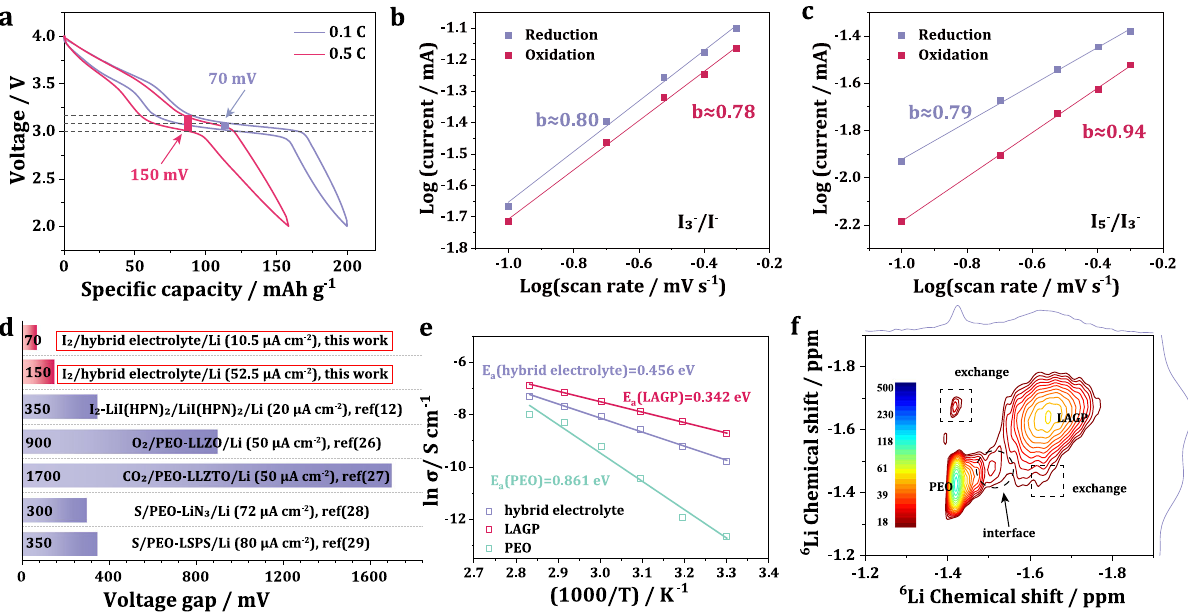
Fig. 5 Reaction kinetics and Li ions transport property in the all-solid-state LIB. a Voltage gap of the all-solid-state LIB at 0.1C and 0.5C. b , c Plots of log( i ) versus log ( v ) at speci fi c peak currents extracted from the CV scans of ( b ) I 3 − /I − and ( c ) I 5 − /I 3 − redox couples. d Literature survey showing the voltage gap of all-solid-state batteries based on typical anion redox chemistry type cathodes, including Li-I 2 battery based on LiI(HPN) 2 electrolyte 12 , Li-O 2 battery based on PEO-LLZO (Li 7 La 3 Zr 2 O 12 ) composite electrolyte 26 , Li-CO 2 battery based on PEO-LLZTO composite electrolyte 27 , Li-S battery based on PEO-LiN 3 composite electrolyte 28 and Li-S battery based on PEO-LSPS (Li 10 SnP 2 S 12 ) composite electrolyte 29 . e Li-ion transport activation energy in PEO, LAGP and hybrid electrolyte calculated from EIS measurements. f 2D exchange 6 Li NMR spectrum of the mixture of PEO and LAGP for a t mix of 0.1